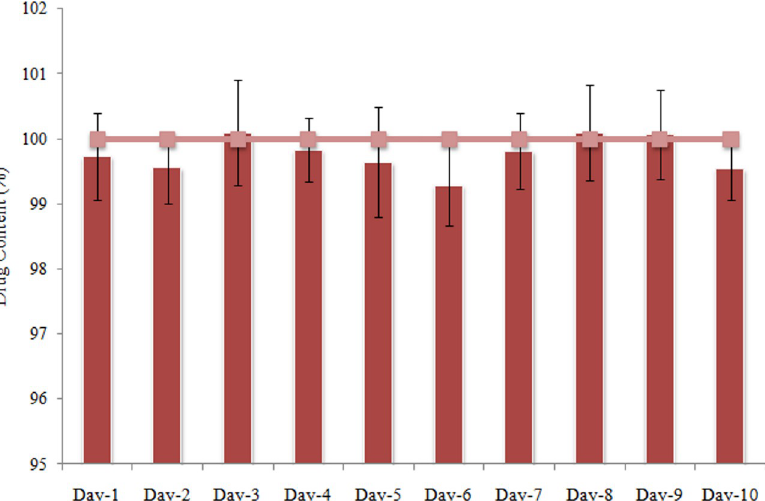
Fig 2. Drug content of clopidogrel solutions prepared in liquid vehicle (PG + water, 2:1 v/v) at specified time intervals (24 h) after storage at 45 ± 5˚C and 75 ± 5% relative humidity.